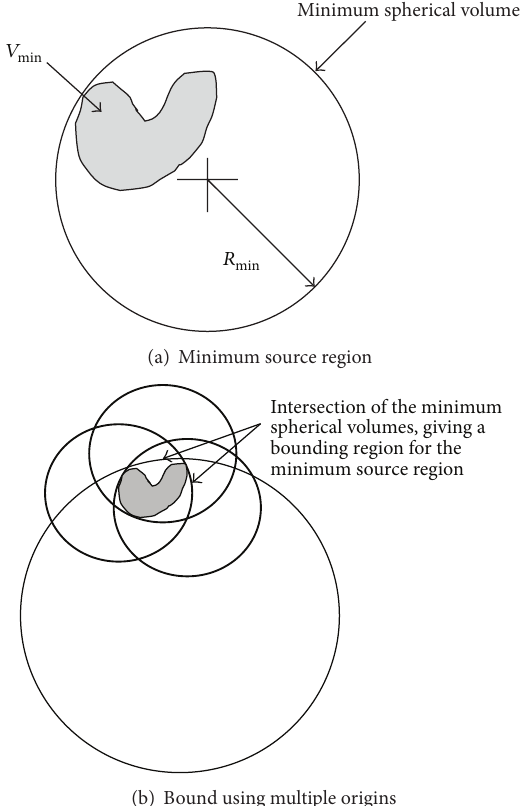
Figure 1: (a) Minimum source region 𝑉 min and the minimum spherical volume 𝐵 min (𝑂) for a given origin 𝑂 . (b) Bounding region for the minimum source region obtained from the intersection of minimum spherical source regions for different origins.